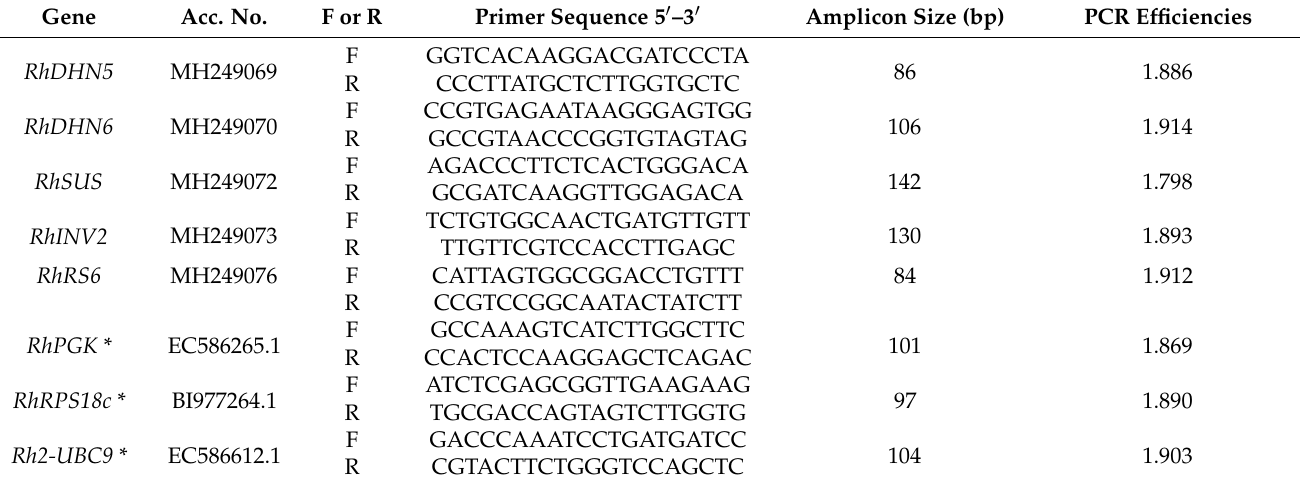
Table 2. List of RT-qPCR primer sequences and product size for Rosa spp . target gene fragments and reference genes. Gene Acc. No. F or